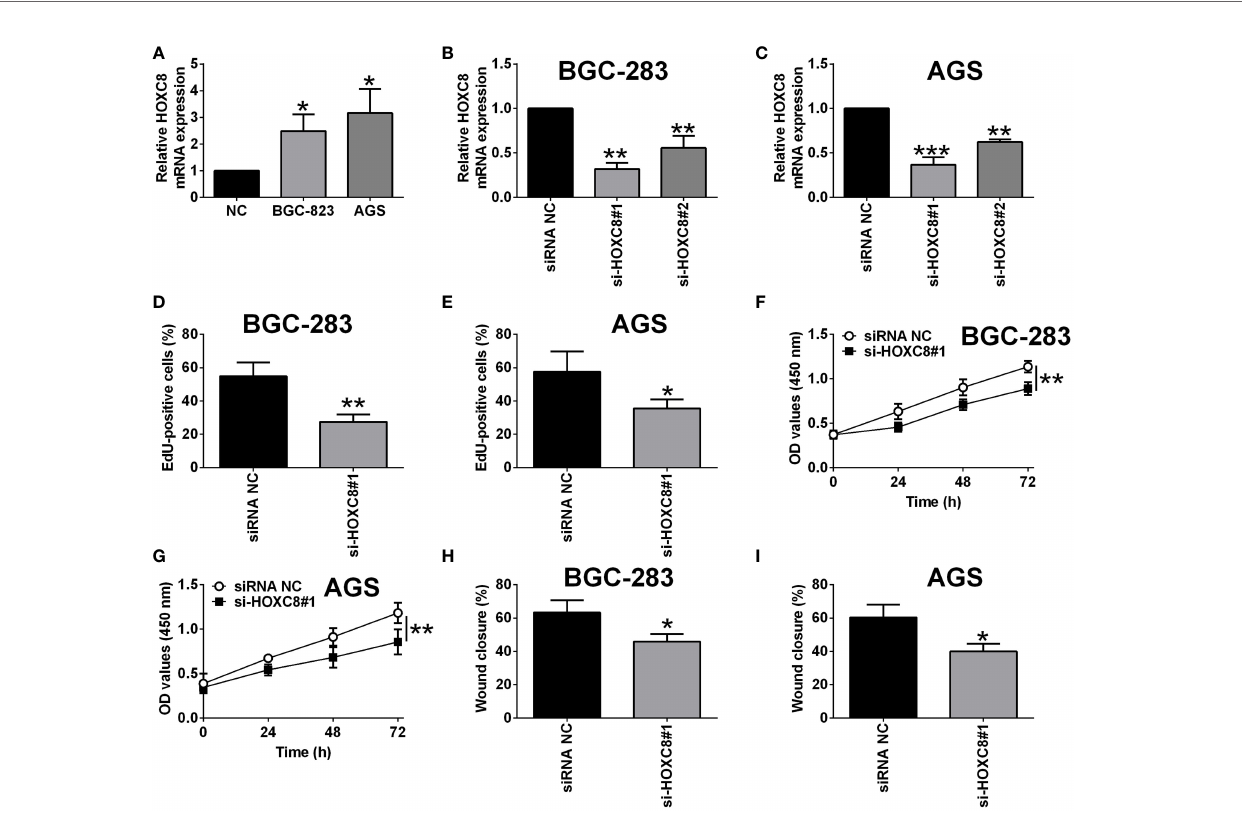
FIGURE 8 | Knockdown of HOXC8 suppressed gastric cancer cell proliferation and migration. (A) HOXC8 mRNA expression level in GES-1, BGC-823 and AGS cells was determined by qRT-PCR. (B, C) BGC-823 cells and AGS were respectively transfected with HOXC8 siRNAs or the corresponding negative controls, and at 24 h after transfection, the relative mRNA expression of HOXC8 was determined by qRT-PCR. (D-I) BGC-823 cells and AGS were respectively transfected with HOXC8 siRNAs or the corresponding negative controls, at 24 h after transfection, the cell proliferation of BGC-823 (D) and AGS (E) was determined by EdU incorporation assay; the cell viability of BGC-823 (F) and AGS (G) was determined by CCK-8 assay; the cell migration of BGC-823 (H) and AGS (I) was determined by wound healing assay. N = 3. *P < 0.05, **P < 0.01 and ***P <